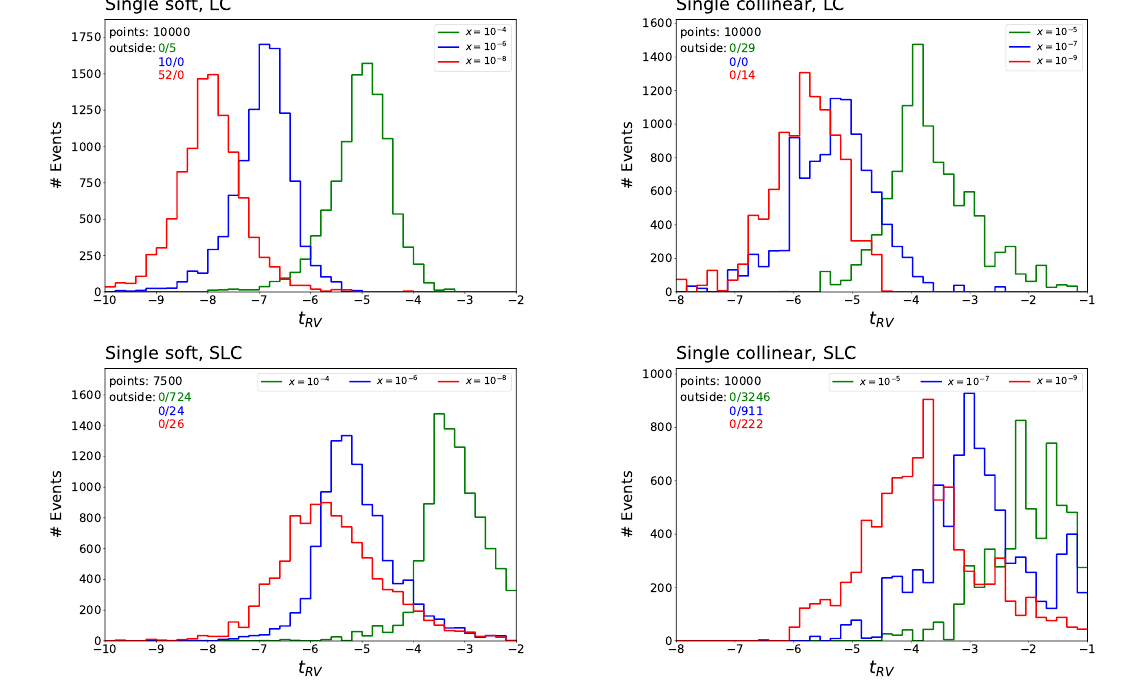
Figure 2 . Test of the real virtual subtraction term in single soft (left) and single collinear (right) limits for the leading colour (upper plots) and subleading colour (lower plots)